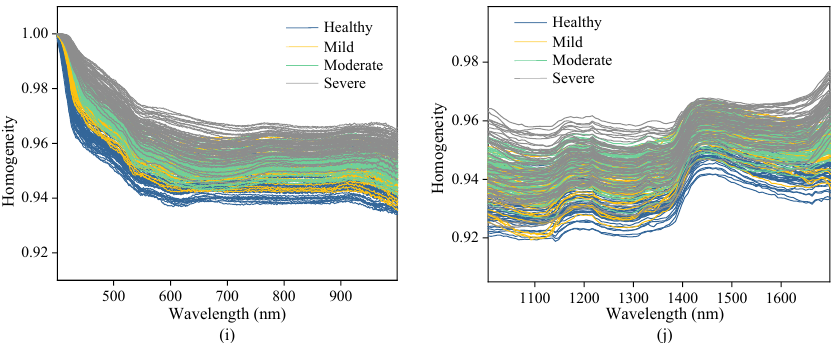
Figure 4. Spectra and texture curves of maize with different moldy levels in the Vis-SWNIR region (left) and LWNIR region (right): ( a ) original spectra in Vis-SWNIR region; ( b ) original spectra in LWNIR region; ( c ) contrast parameter in Vis-SWNIR region; ( d ) contrast parameter in LWNIR region; ( e ) correction parameter in Vis-SWNIR region; ( f ) correction parameter in LWNIR region; ( g ) energy parameter in Vis-SWNIR region; ( h ) energy parameter in LWNIR region; ( i ) homogeneity parameter in Vis-SWNIR region; ( j ) homogeneity parameter in LWNIR region.